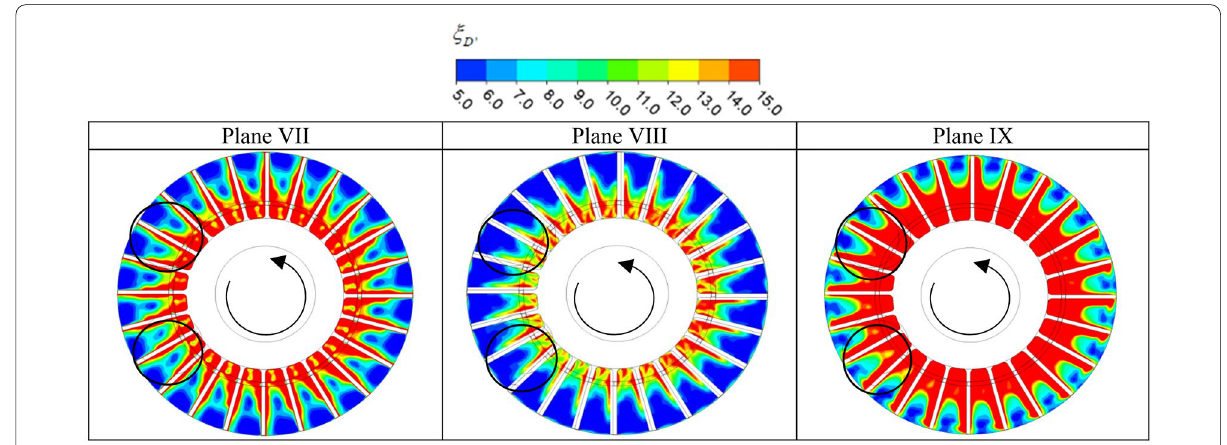
Figure 17 Distributions of entropy loss on axial